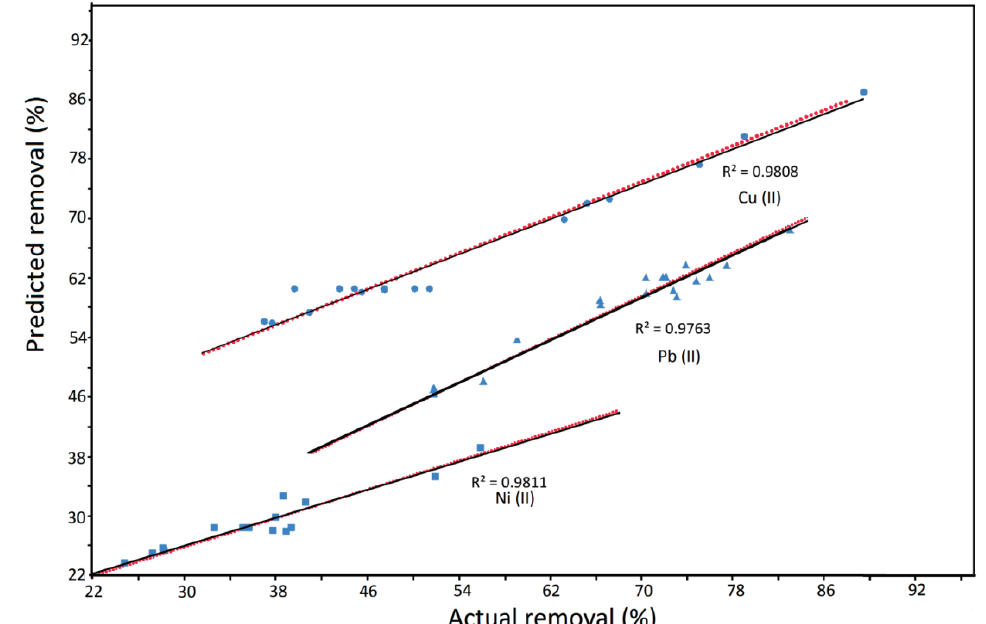
Figure 1. Actual results versus predicted results. Solid lines: experimental results; dashed lines: Predicted